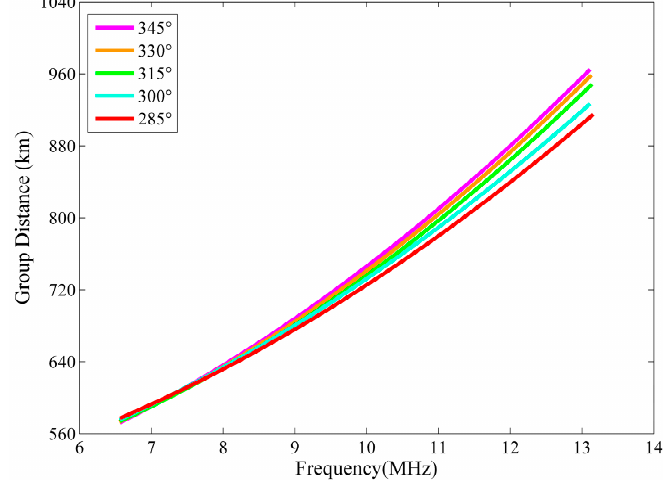
Figure 12. The leading edges of the oblique backscatter swept-frequency echoes of the five beams.